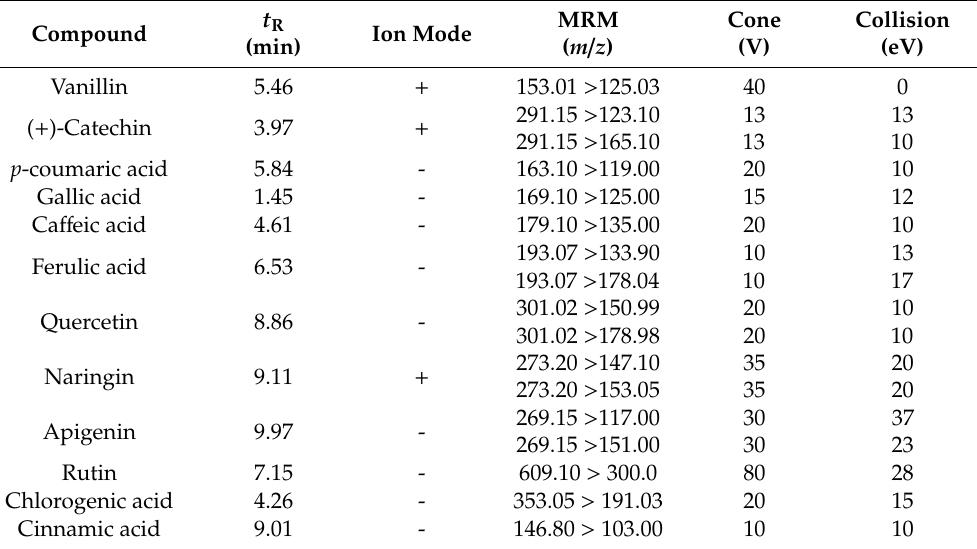
Table 4. Mass spectrometric conditions for each